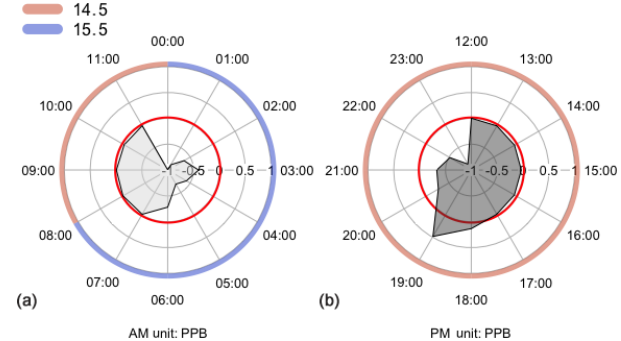
Figure 21. CH 4 mixing ratios difference between HR and HR_RESHIFT in domain 3 for unconventional wells. Panel (a) shows the differences between 00:00 and 12:00EST on 14 and 15 May. Panel (b) shows the differences between 12:00 and 24:00EST on 14